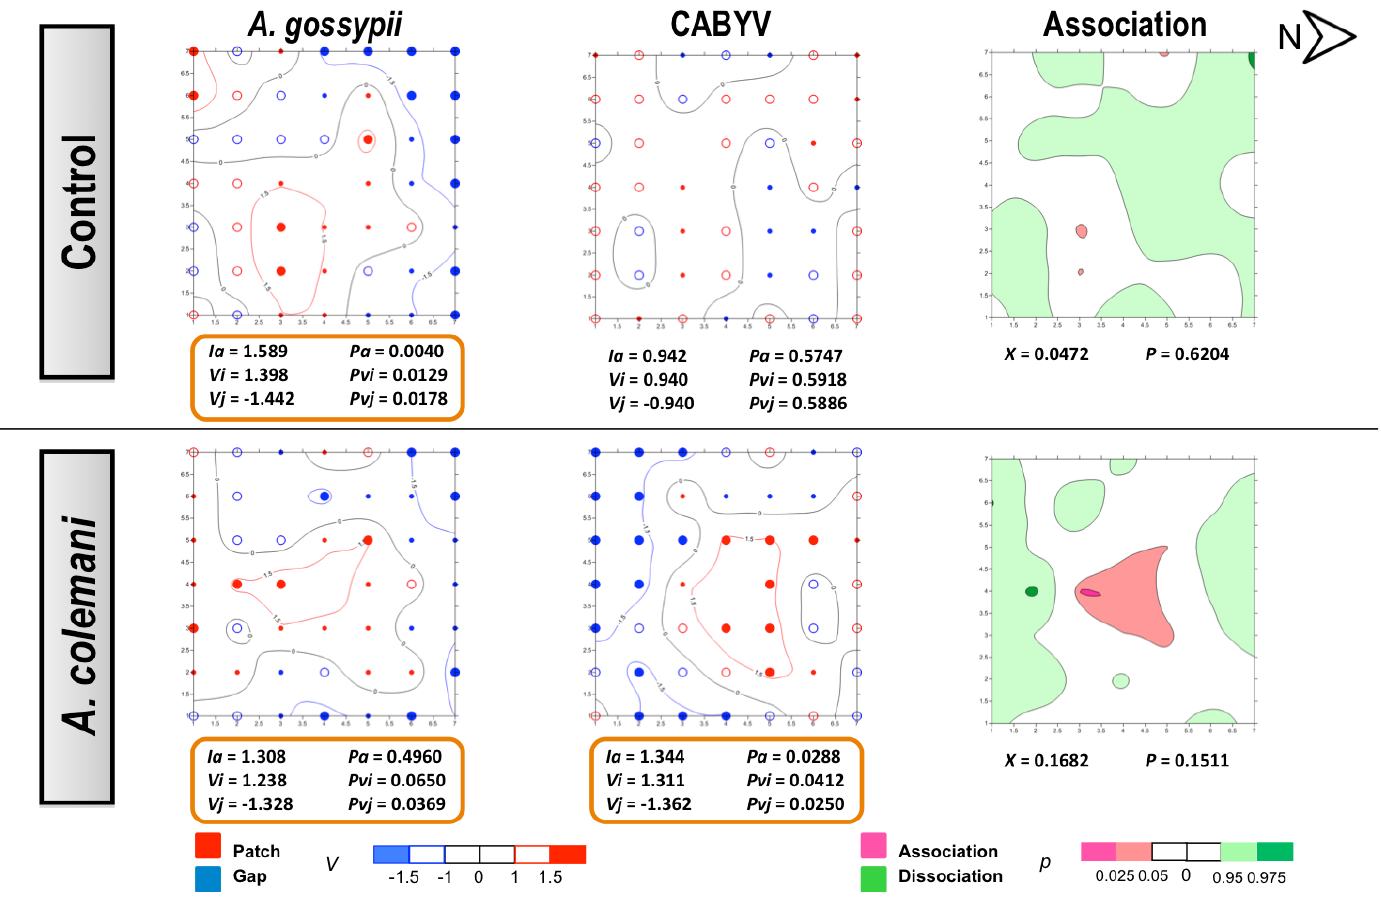
Figure 6. Classed post maps of the spatial distribution of mean number of A. gossypii and cumulative number of CABYV-infected plants (total number of infected plants per treatment) at 14 days, and contoured map of the association between CABYV-infected plants and its vector, A. gossypii . Symbols and contours are as for Figure